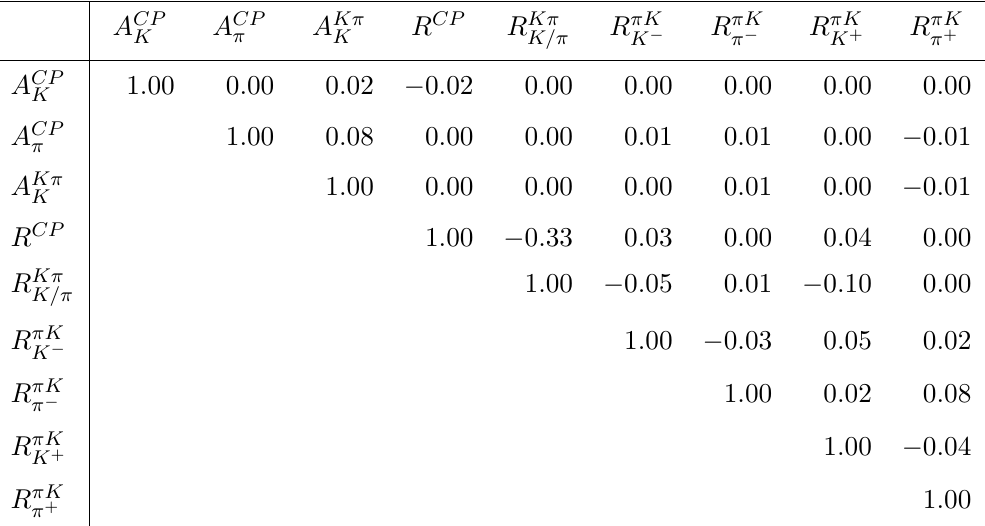
Table 5 . Statistical correlation matrix for B ± → Dh ± observables.